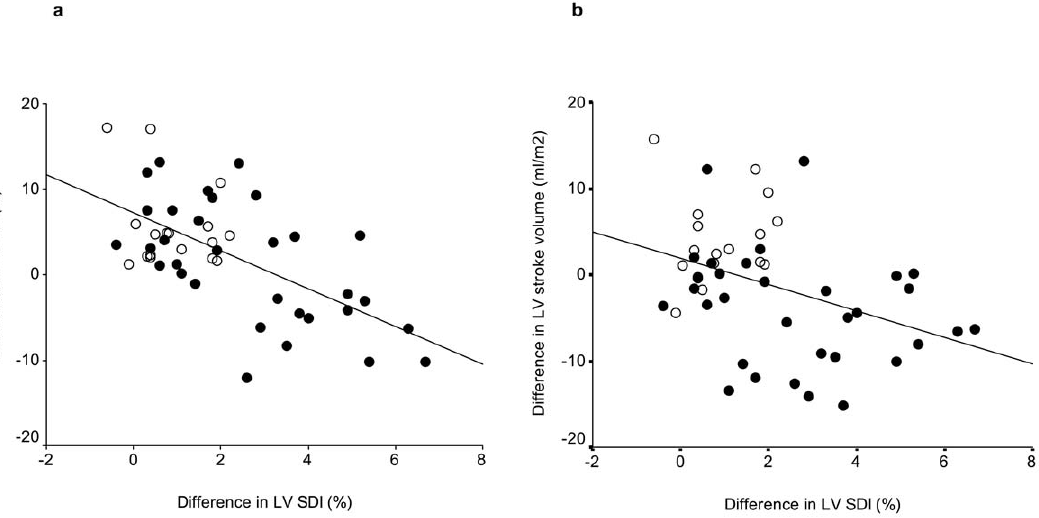
Figure 3. Scatter plot showing a negative correlation between exercise-baseline differences in left ventricular (LV) systolic dyssynchrony index (SDI) and exercise-baseline differences in (a) LV ejection fraction (EF) and (b) indexed LV stroke volume (closed circles: patients, open circles: controls).